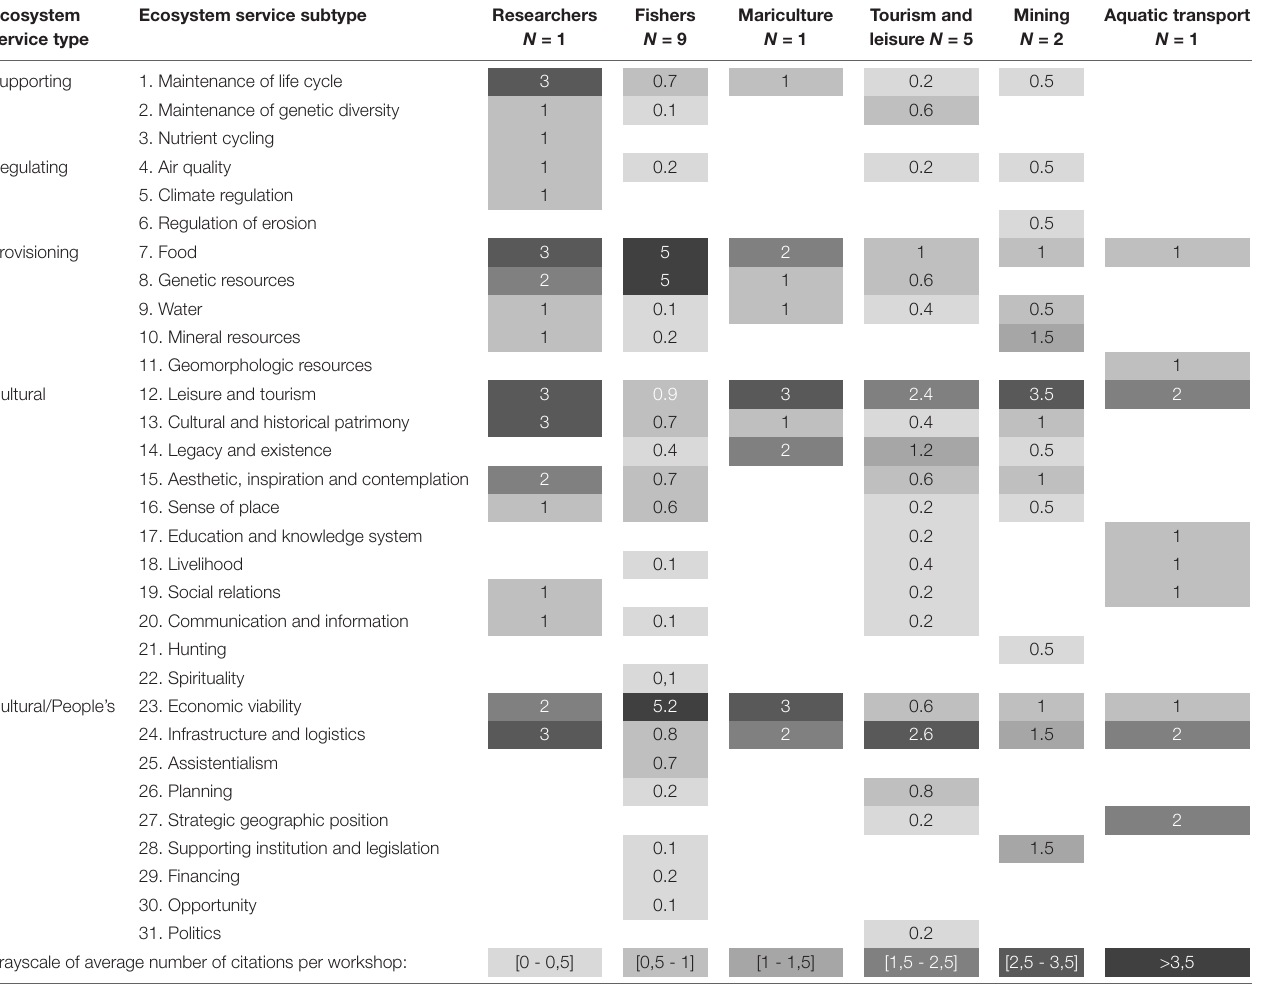
TABLE 2 | Structure of Ecosystem Services classification profiles by direct resource users (N = number of workshops) of Babitonga Bay (Santa Catarina, Brazil). Ecosystem service